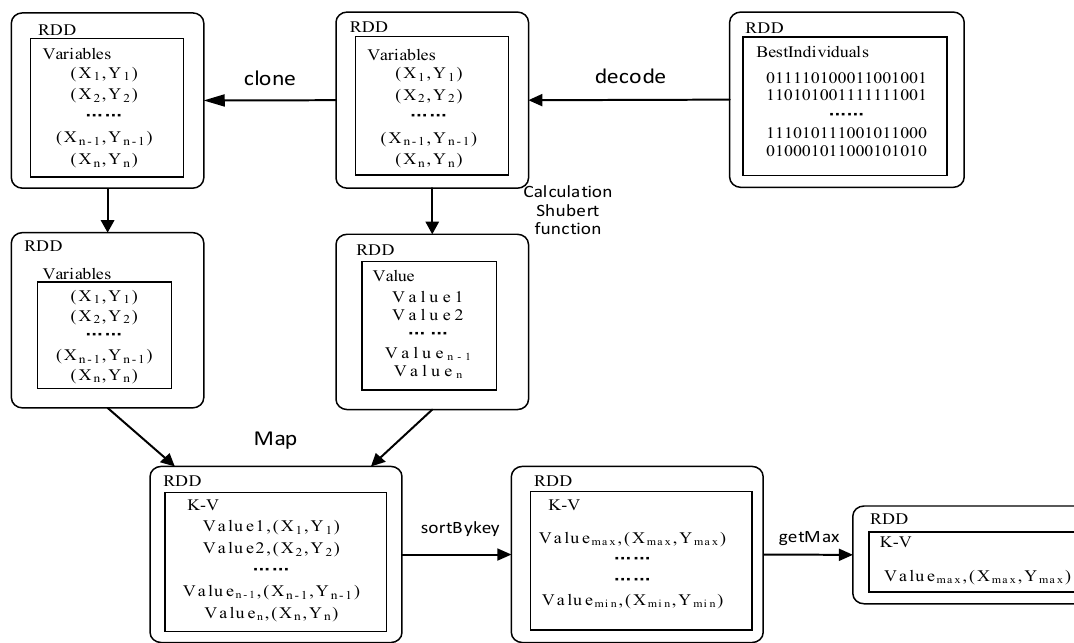
Figure 9. Searching optimal extremums for SMPF based on RDD.